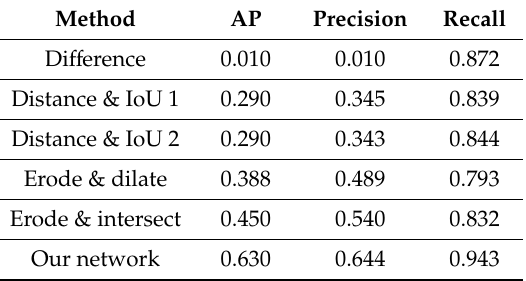
Table 4. Di ff erent methods to discover changed building instances from the bi-temporal building classification map produced by the Mask R-CNN. “Di ff erence” indicates the direct di ff erencing of the two classification maps; “Distance & IoU 1” indicates a threshold of a 20-pixel shift of center points of corresponding building masks, and 0.33 IoU is used to determine if the two masks of di ff erent times are the same buildings. “Distance & IoU 2” indicates a threshold of a 20-pixel shift of center points of corresponding building masks, and 0.5 IoU is used. “Erode & dilate” indicates we used a morphological erosion operation to eliminate small masks and alignment errors and a dilation operation to restore buildings. “Erode & intersect” indicates that we used an erosion operation followed by an intersection operation with a threshold of 0.5 IoU. “Our network” is the change detection network trained with simulated samples.